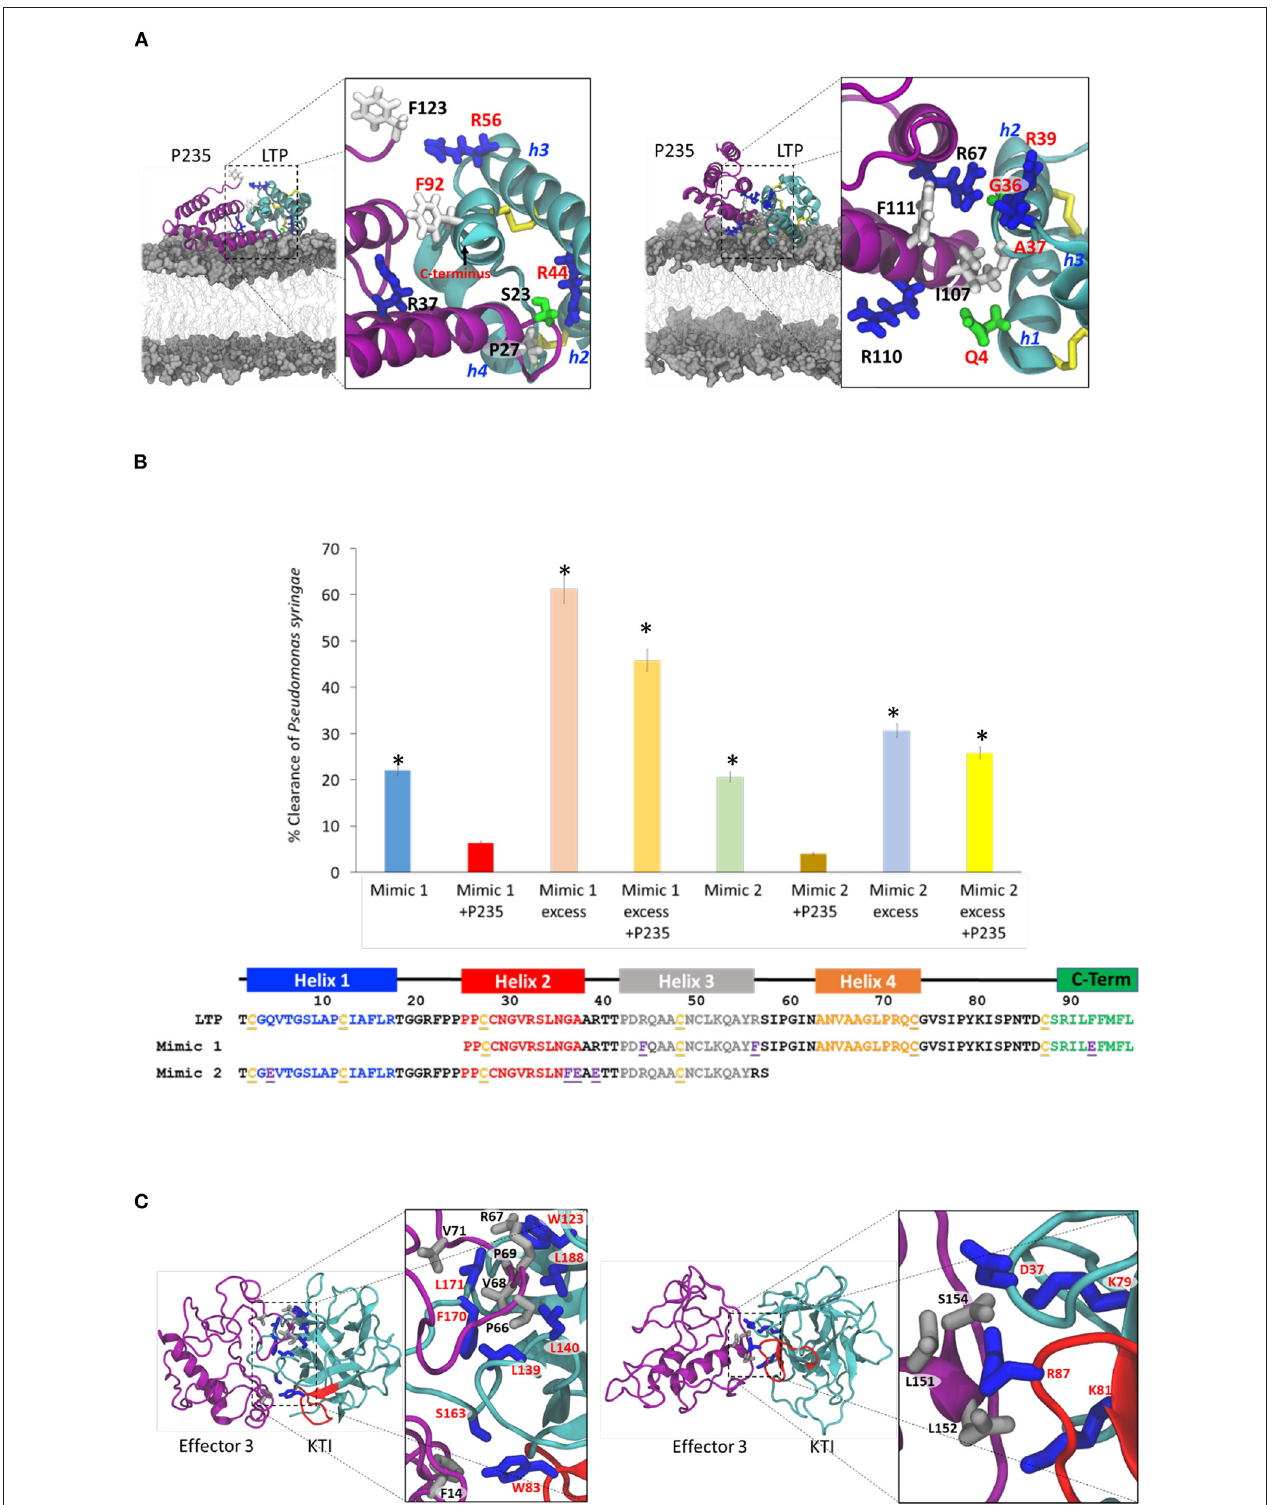
FIGURE 4 | Prediction and validation of (citrus target– C Las effector) interaction at the contact interface. Molecular modeling is performed to predict the pairwise interactions based on which mimics are designed to displace the effector from the (citrus target- C Las effector) complex. Finally, experiments are performed to determine if the mimic, indeed, displaces the effector from the complex and if so, our prediction of the pairwise interactions are validated. (A) Two possible modes of